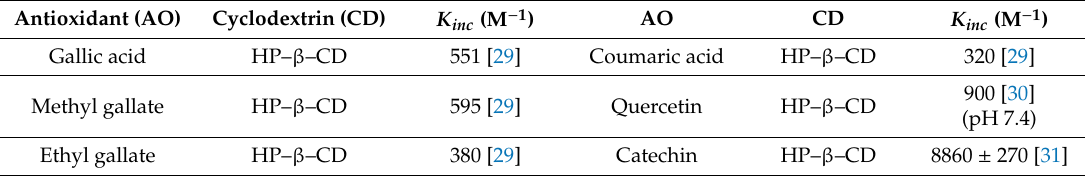
Table 1. Inclusion constants, K inc , for gallic acid and some derivatives and some polyphenols commonly detected in Bryophyllum extracts [13]. Values for gallic acid (GA) and its derivatives were obtained in this work by employing (a) the spectral shift method and (b) the solubility method (see Section 3.10). Reported values were calculated assuming a 1:1 stoichiometry in unbu ff ered water solutions at T = 25 ◦ C, except where otherwise